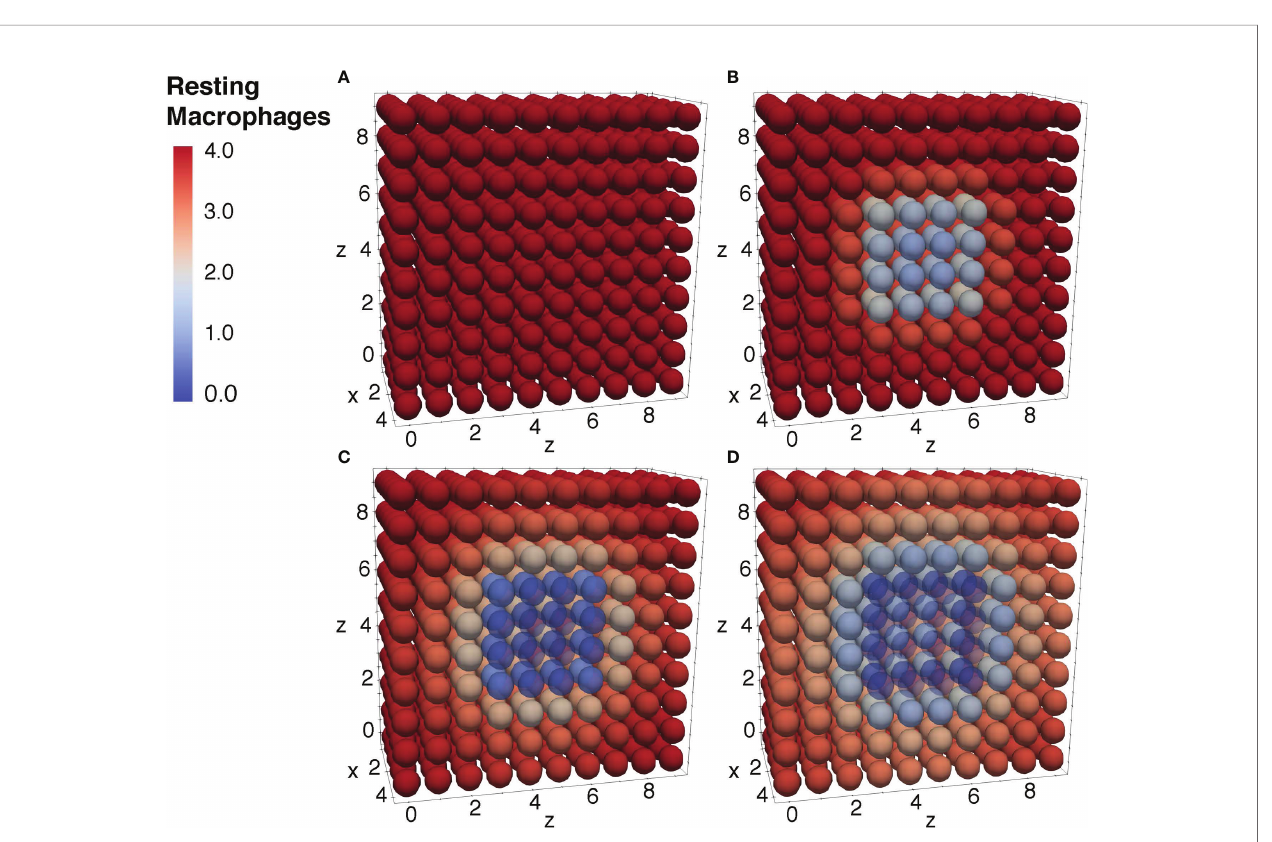
FIGURE 9 | Diffusion of the resting macrophages at different time periods. Initial condition of the resting macrophages (A) , after 3h of simulation where the values decrease as a result of change of state from resting to activated (B) , after 12h of simulation (C) , and after 24h of simulation (D)